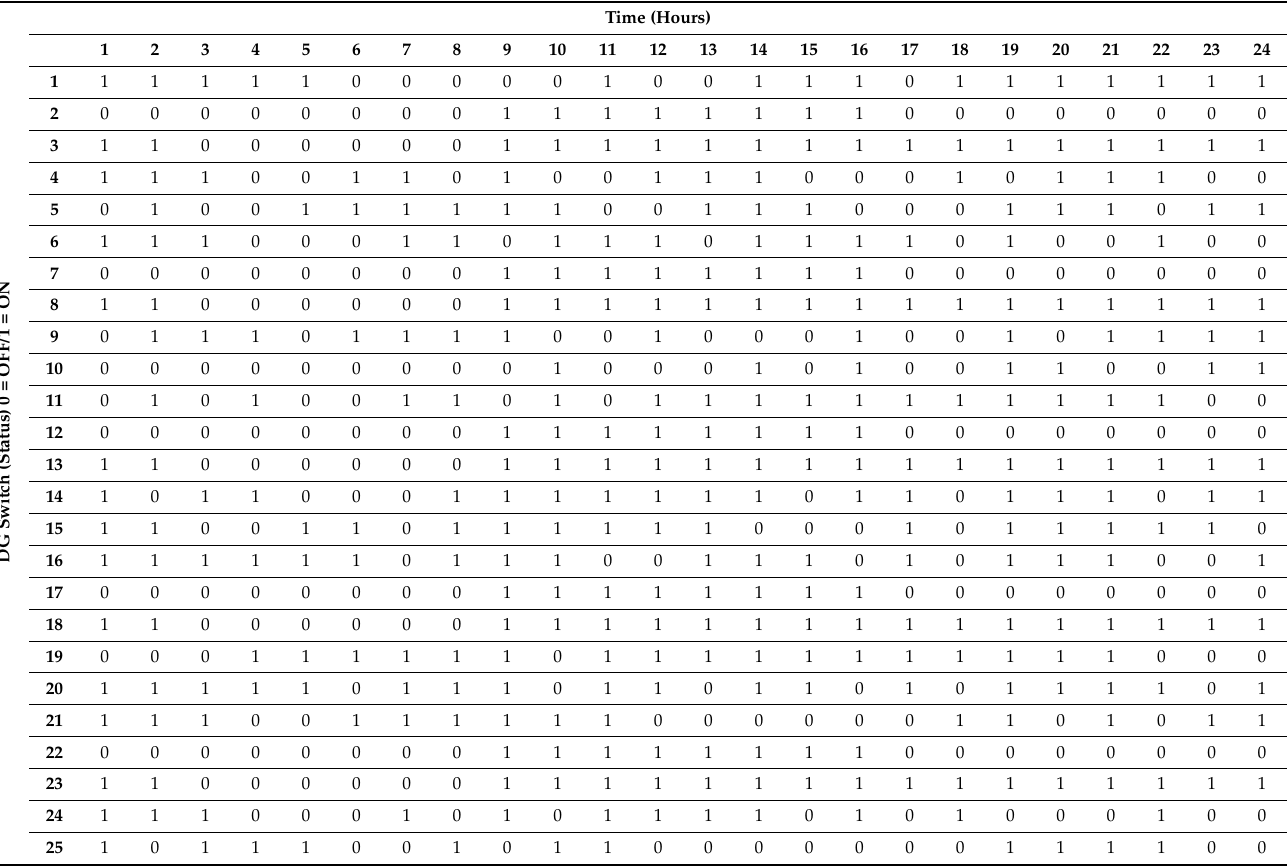
Table 5. The optimal schedule obtained from the BBSA optimization algorithm.